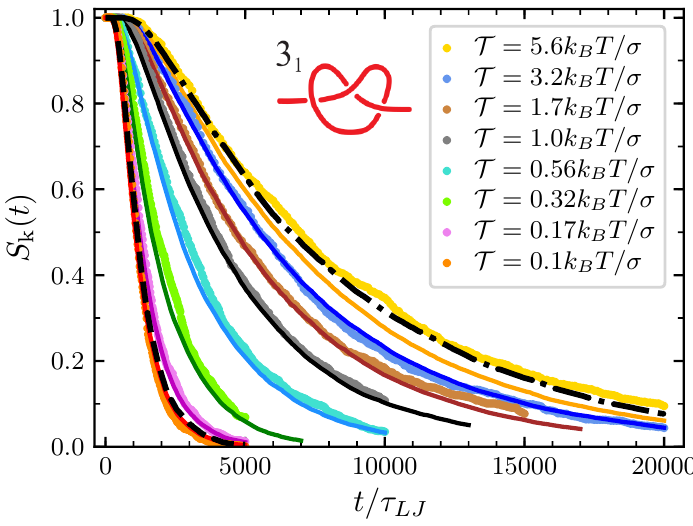
Figure 6. Survival probability of the 3 1 ( n k = 3) at the various value of from MD simulations and the corresponding full lines are the prediction of the model. Dashed black line on the left is the prediction of the free diffusive model with n k = 3 and the same diffusion coefficient D used in the general model. Dash-dotted line on the right is the prediction in the strong force